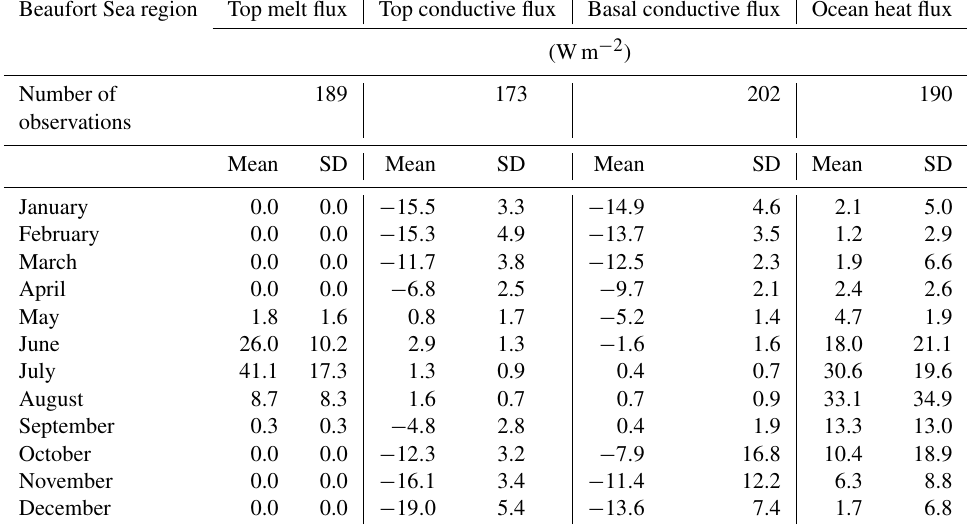
Table 3. Means and standard deviations of fluxes measured from the IMB data in the Beaufort Sea region (in Wm − 2 ), in each month of the year. For each flux, the convention is that downwards is